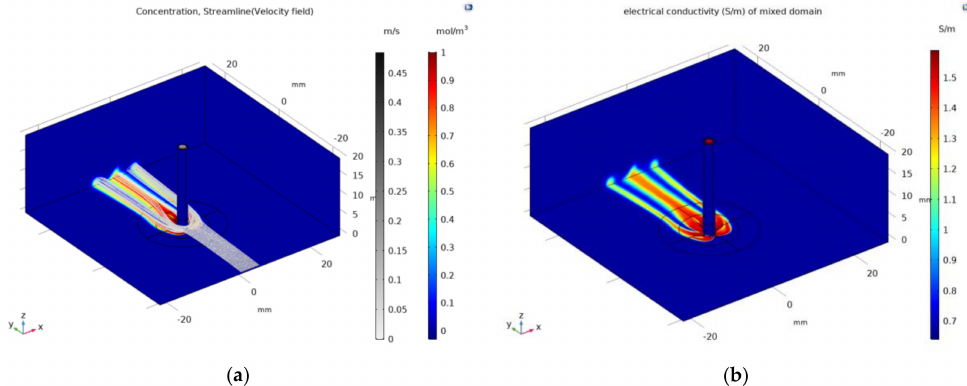
Figure 7. Concentration distribution and streamline in the model that considers mixing between saline and blood ( a ) and distribution of electrical conductivity calculated using Equation (7) ( b ).